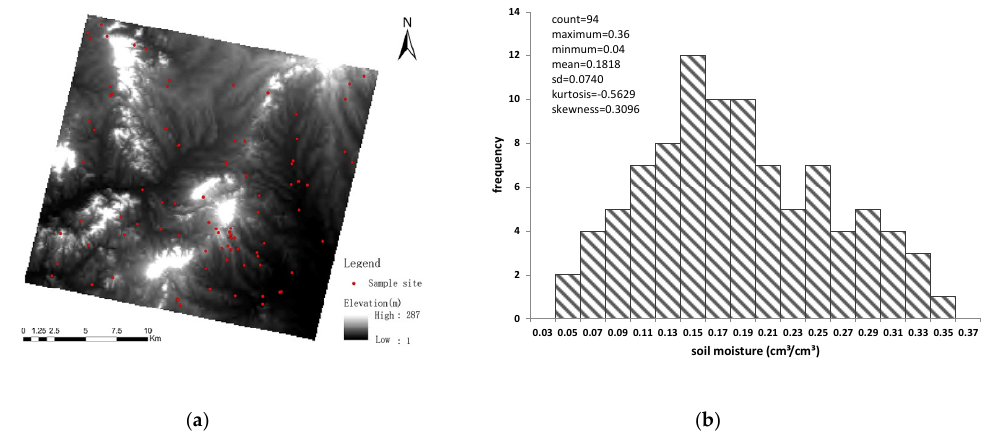
Figure 2. Map of sampling sites and elevation ( a ) and statistical characteristics of measured soil moisture samples ( b ).